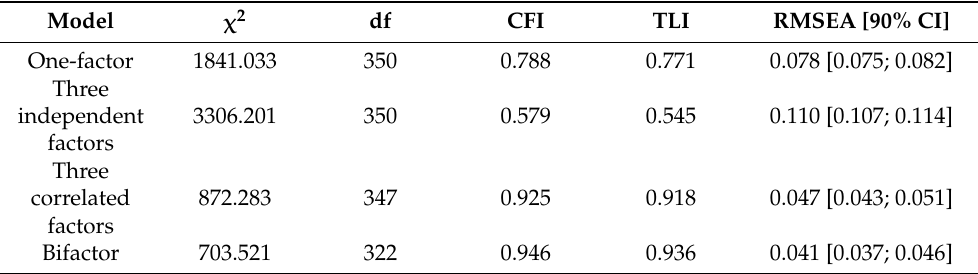
Table 4. Goodness-of-fit indices for the confirmatory factor analysis models on the second random subsample ( n =